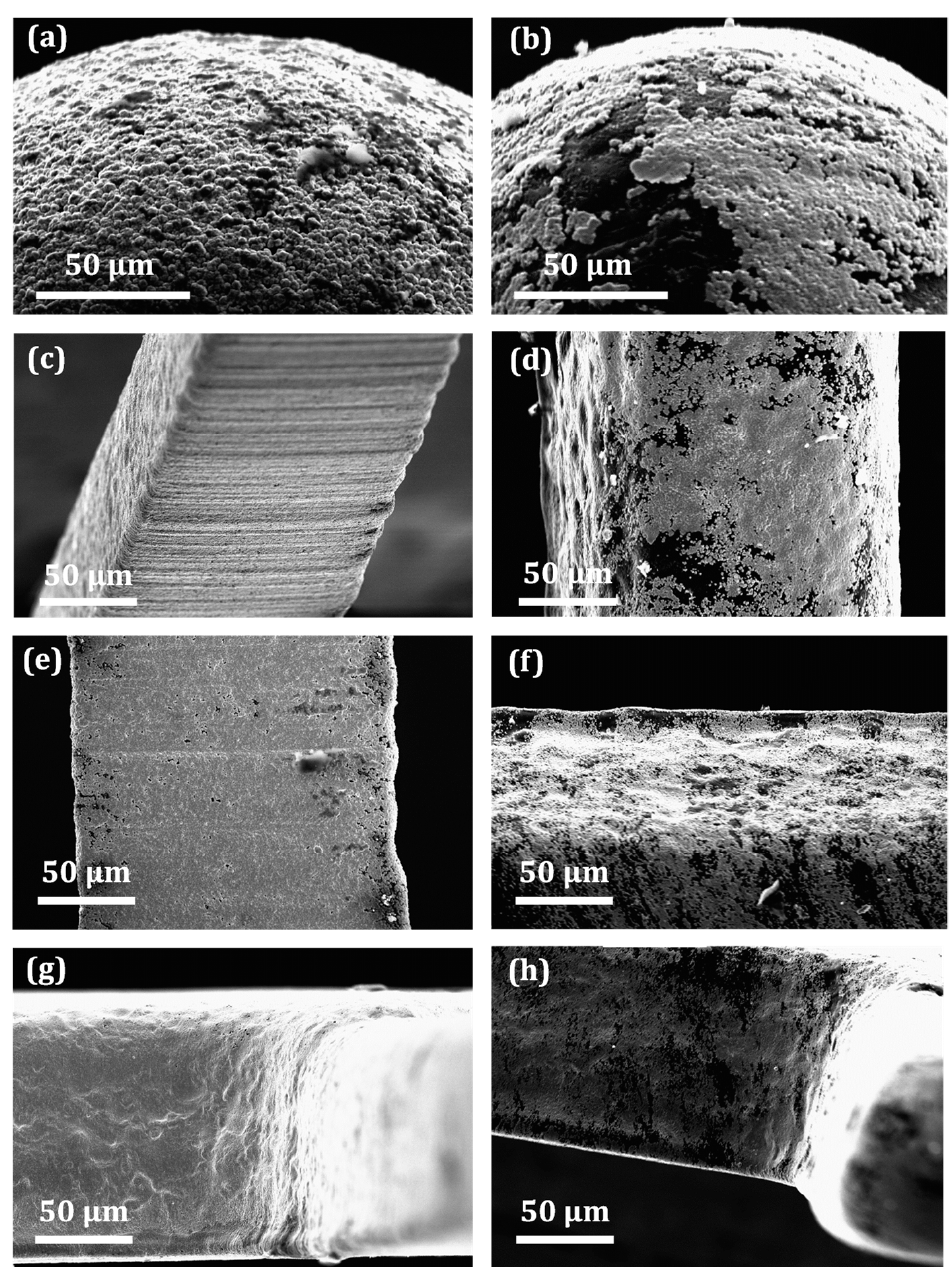
Figure 6. Quality of metallization on critical areas of the part—better metallization on ABS (left column), worse on PC-ABS (right column): fingertips ( a , b ); side walls ( c , d ); edges ( e , f ); and corners ( g , h ).